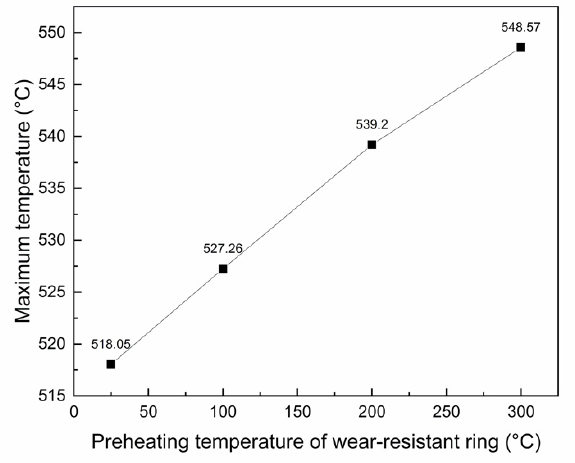
Figure 12. Relationship between the maximum temperature of the inner surface of wear-resistant ring and the preheating temperature.